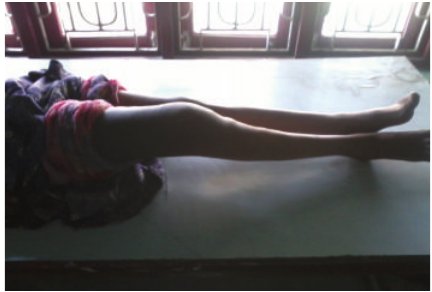
Figure 6: Clinical picture at final